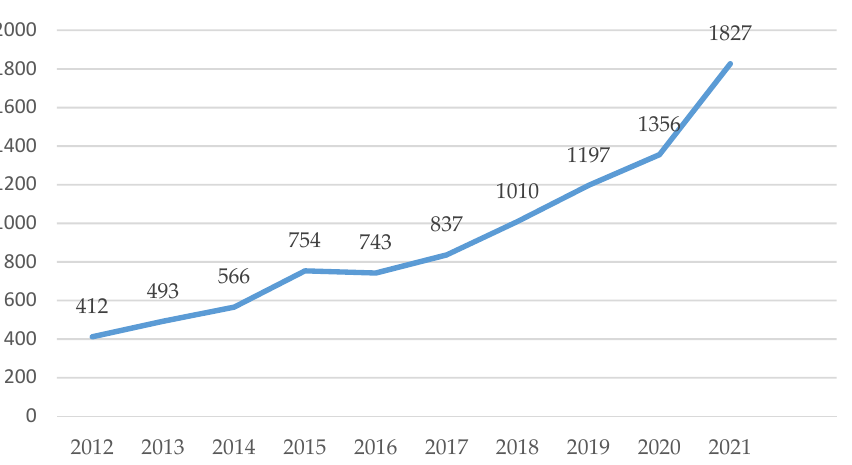
Figure 4. Studies on MCDM—Number of Articles from 2012 to 2021.